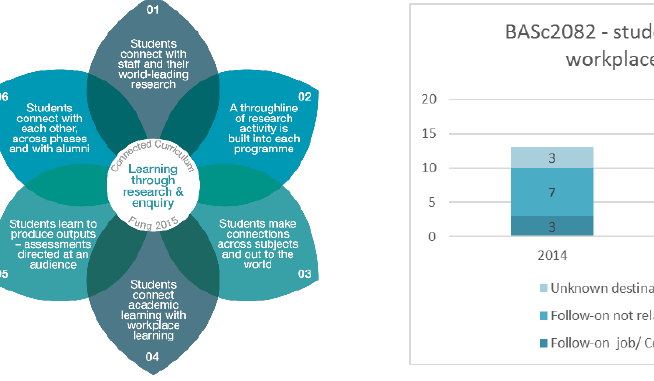
Figure 4. UCL Dimensions of the Connected Figure 5. Development of follow-on activities of BASc2082 students in academic or workplace